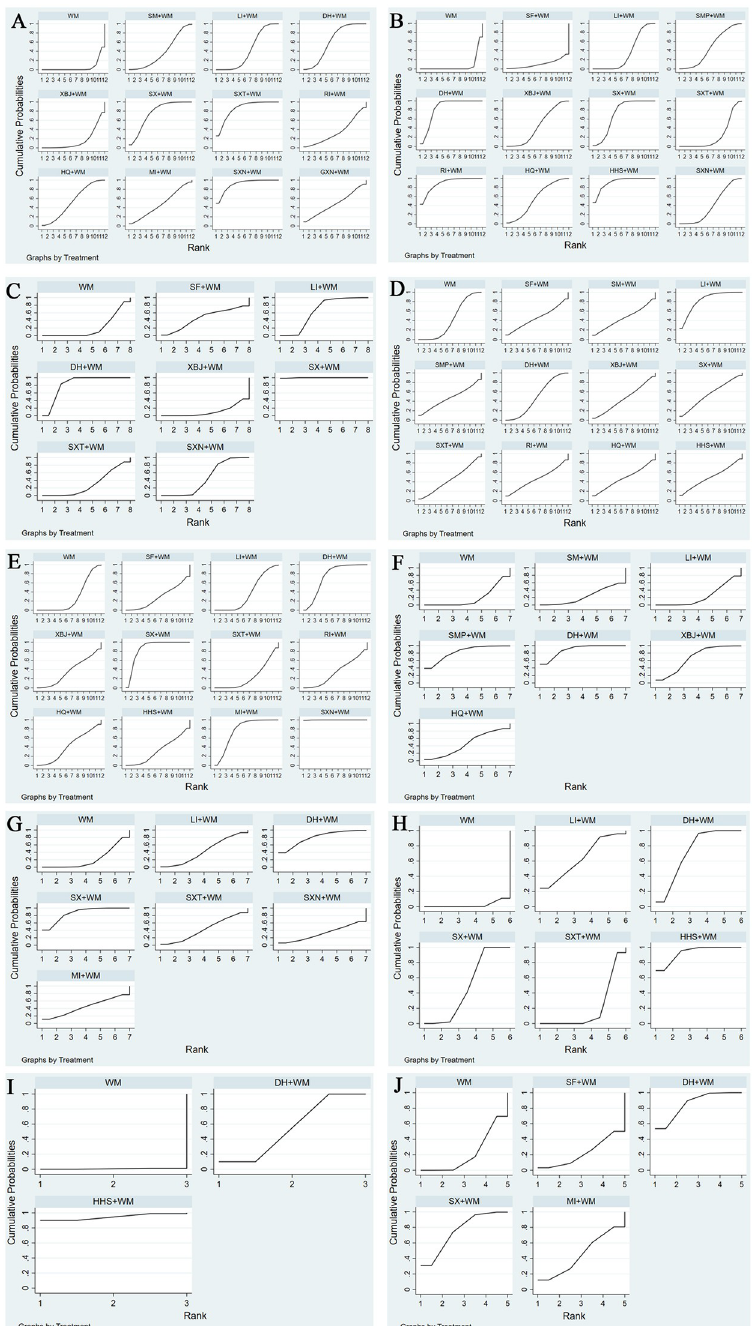
Fig 4. Plot of the surface under the cumulative ranking curves for outcomes. A, CER; B, PaO2; C, PaCO2; D, DLCO; E, FVC; F, TLC; G, FEV1%; H, FEV1/FVC%; I, IIIC; J, TGF.